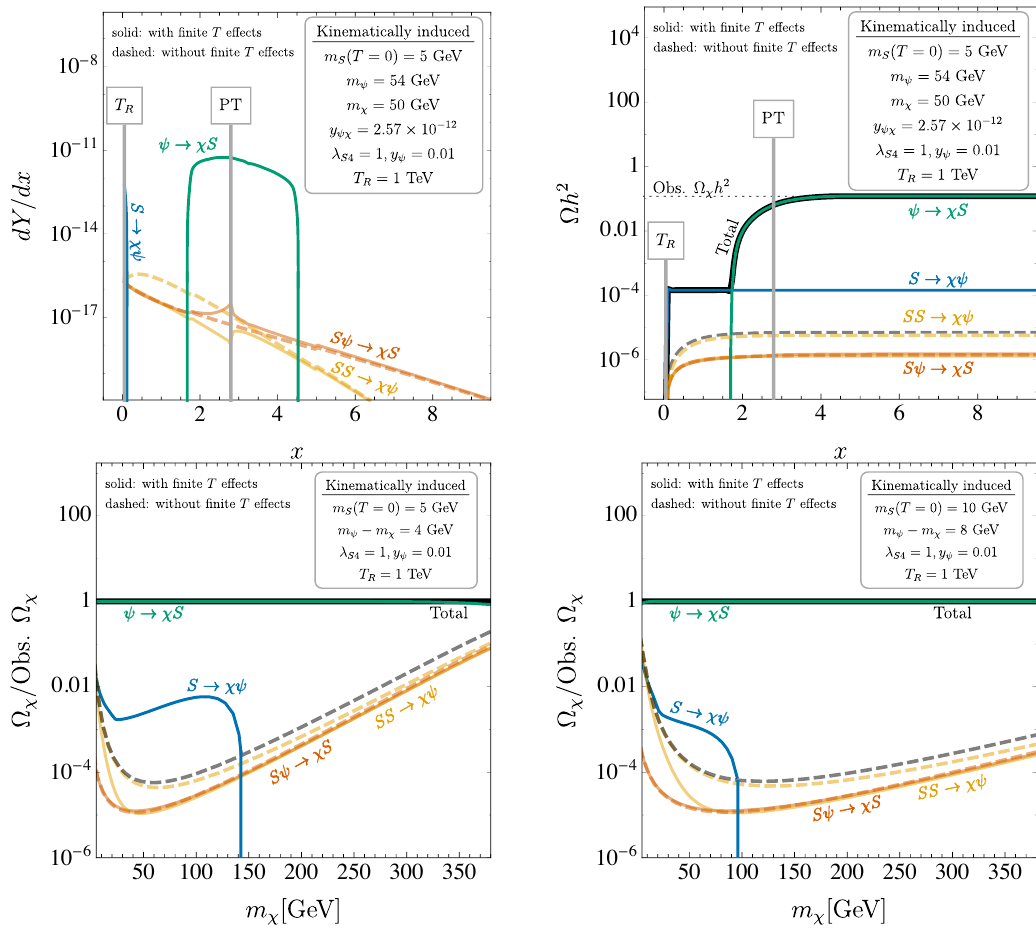
Figure 3 . The instantaneous change in the yield (top-left) and the resulting freeze-in relic abun- dance extrapolated to the present day (top-right) for our benchmark point, including (solid lines) and ignoring (dashed lines) (cid:12)nite temperature e(cid:11)ects. Also shown is the relative (cid:12)nal abundance (normalised to the abundance when (cid:12)nite temperature e(cid:11)ects are included) through each channel as a function of m (cid:31) for m S ( T = 0) = 5 GeV (bottom-left) and m S ( T = 0) = 10 GeV